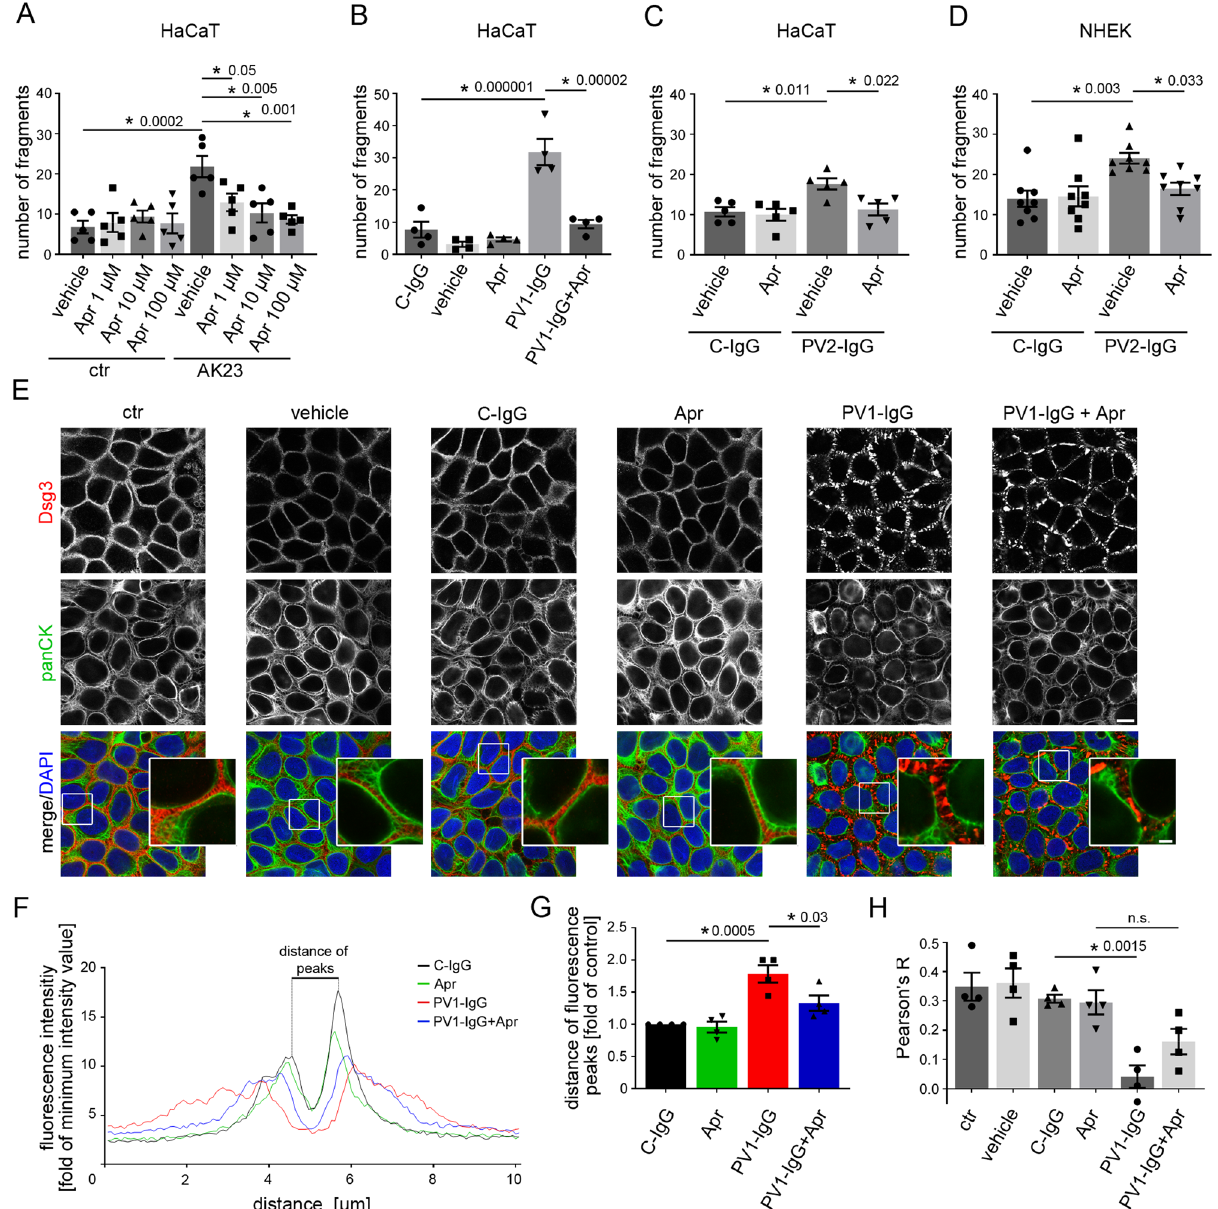
Fig. 2 | Apremilast ameliorates PV-IgG-induced loss of intercellular adhesion and keratin fi lament alterations. A – D Dispase-based keratinocyte dissociation assay of human keratinocytes. 1h pre-incubation of apremilast attenuated anti- Dsg3 antibody (AK23) in a dose-dependent fashion ( A , n =5). 100 µ M apremilast also ameliorated PV1-IgG- ( B , n =4) and PV2-IgG- ( C , n =5) induced loss of cell cohesioninHaCaTcells. D Primarykeratinocytes(NHEK)show sameresultswith PV2-IgG. ( n =8). E Immunostaining of Dsg3 and keratin fi laments (panCK) in HaCaTs.Apremilast(100 µ M)amelioratedPV1-inducedkeratinretractionbutnot Dsg3 depletion and fragmentation of staining. Scale bar=10 µ m. Zoom in areas markedwithwhiterectangles.Scalebar(zoom)=2.5 µ m.Representativeof n =4.